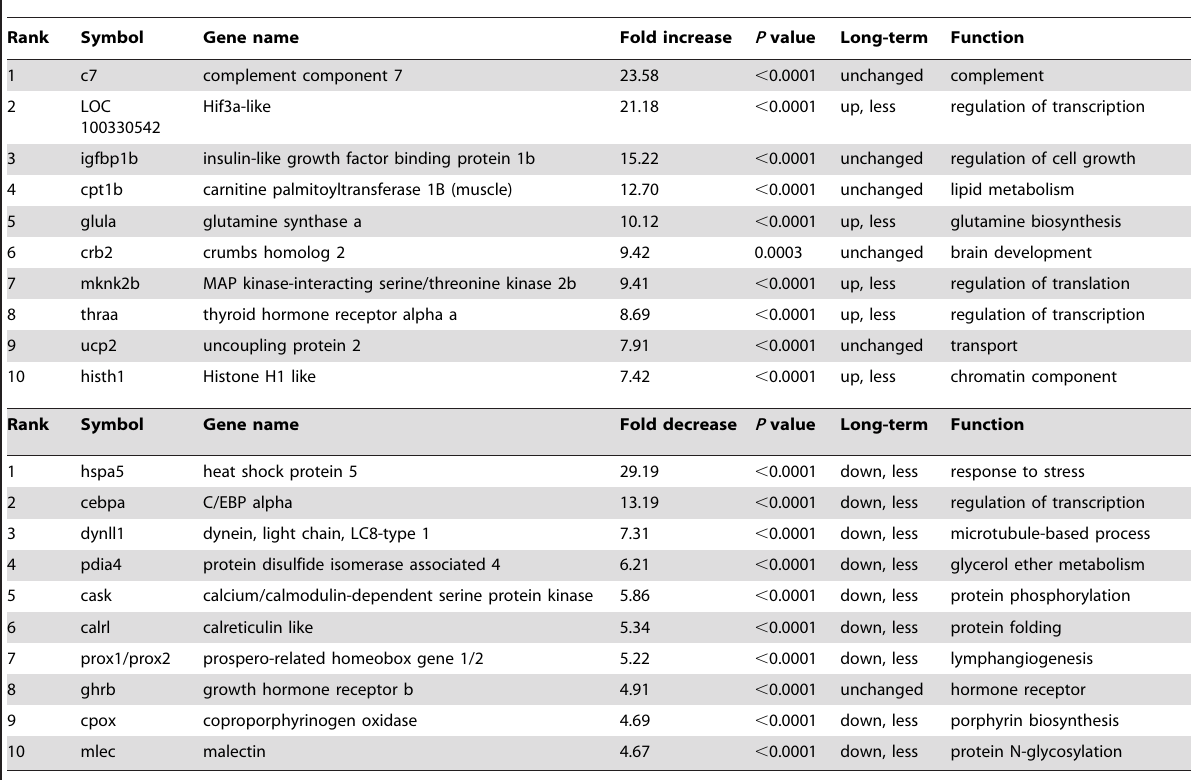
Table 2. Genes increased or decreased as part of the acute response to